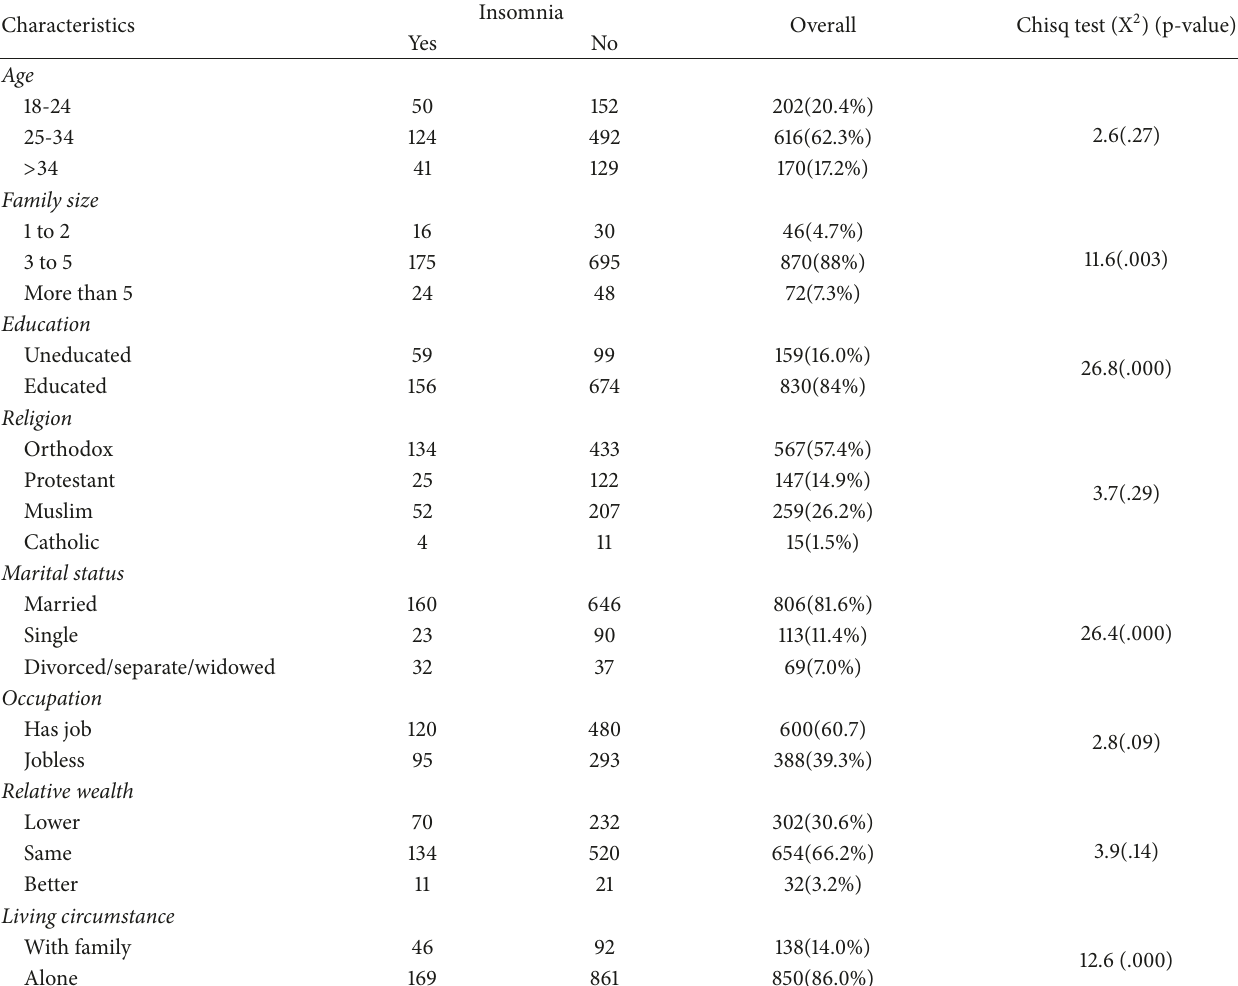
Table 1: Sociodemographic characteristics of the mothers in relation with sleep